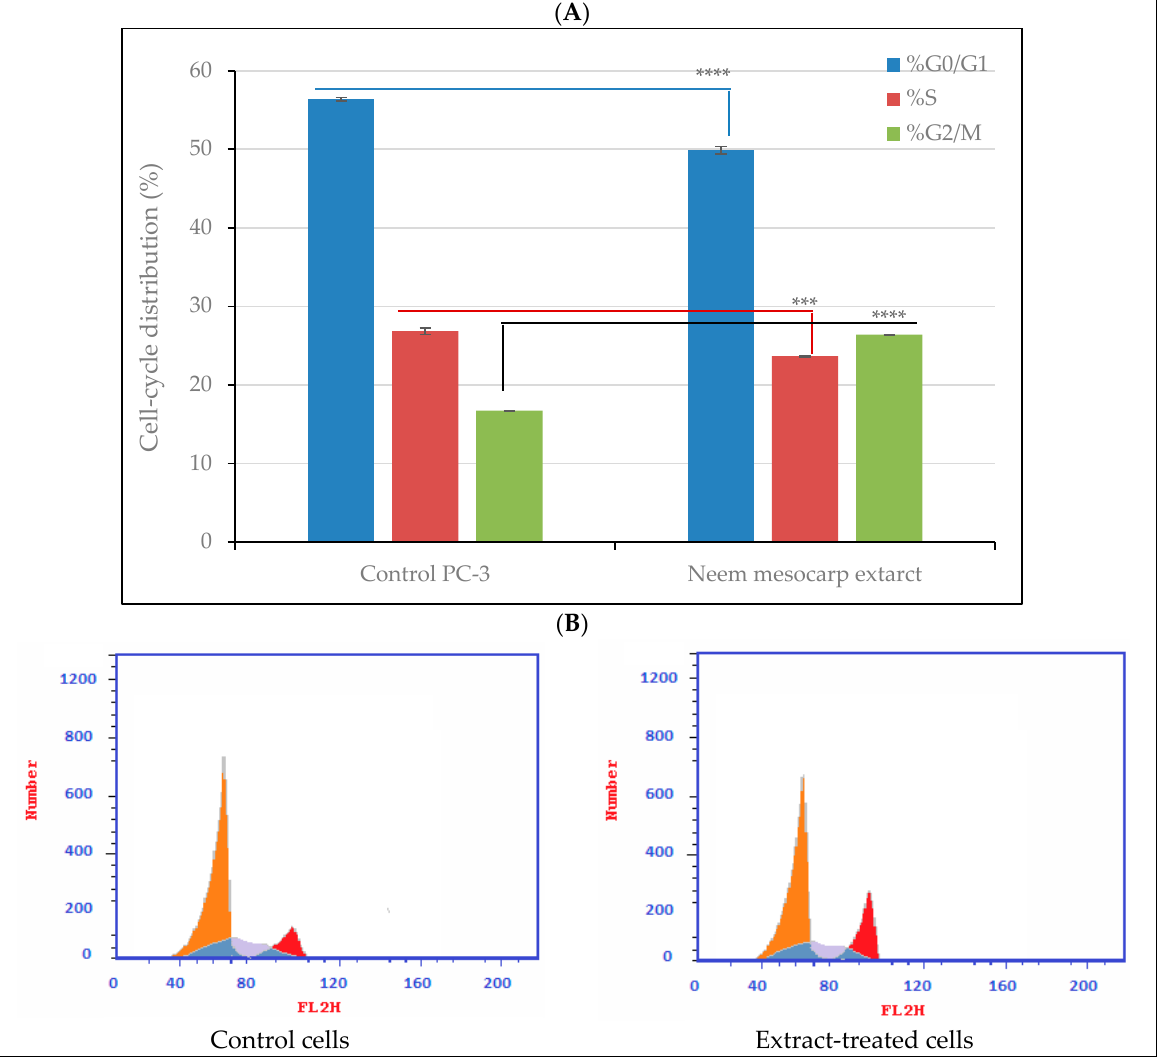
Figure 6. Cell-cycle distribution of PC-3 cells treated with methanolic fruit mesocarp extracts of neem at 111 µg/mL: ( A ) quantitative cell-cycle distribution % illustrated by the bar graph with cell growth arrest@ G2/M; ( B ) flow cytometry histogram showing DNA content of neem extract-treated cells. Significance differences between treated and control cells were determined using unpaired t -test, *** p < 0.001, and **** p < 0.0001. The data presented are the means of three replicates; ±SD indicated by the vertical bars.